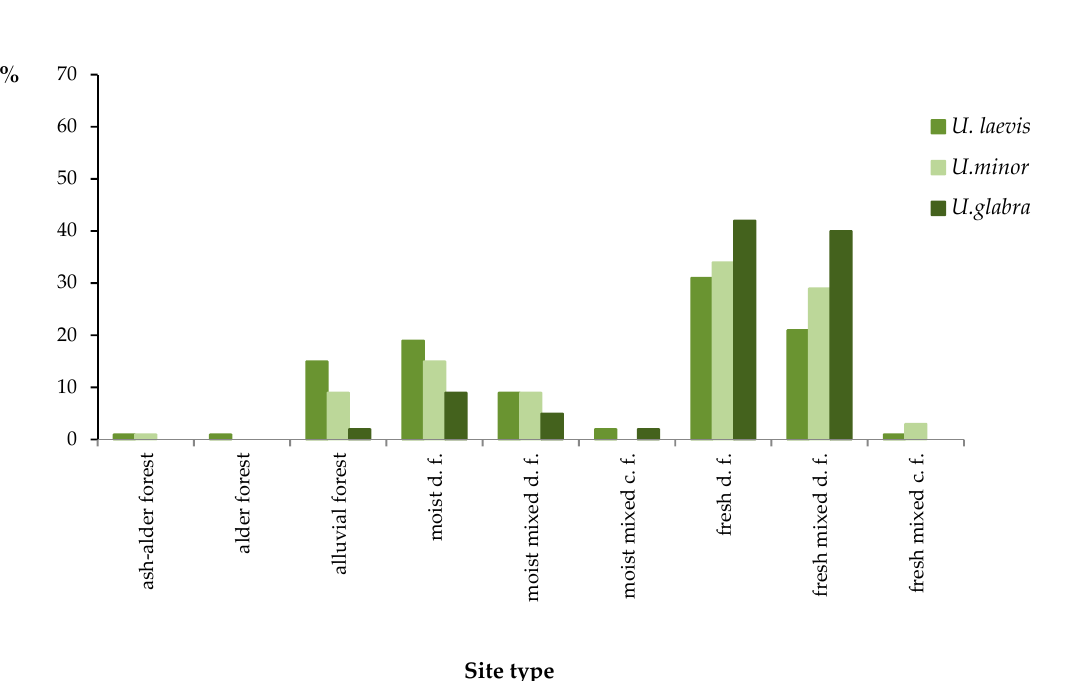
Figure 5. Percentage of individual elm localities in ‘forest site types’ (FST) according to forest documentation (distinguished by soil classification). c.f.—coniferous forest, d.f.—deciduous forest.